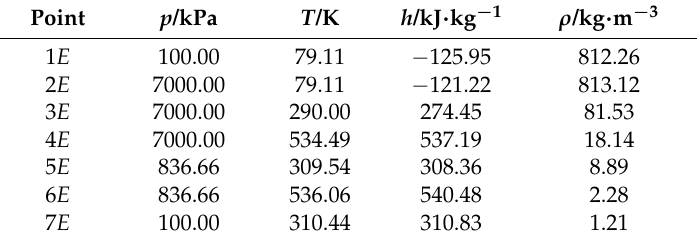
Table 3. Parameters of the points in the electric generation process.